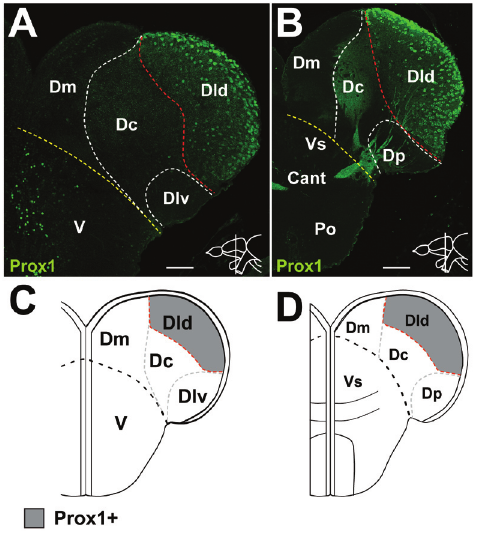
Figure 3. Expression of Prox1 in the pallium. A . At mid-telencephalic levels, Prox1 positive cells are found in the neuronal layer (nl) of Dld shortly before the anterior commissure (Cant). B . At Cant, Prox1 positive cells are found in the nl of Dld. C .– D . Summary of expression pattern of Prox1. A .– B . Confocal images of cross-sections at the levels indicated through the telencephalon. Red dashed line indicates subdivisions based on the current marker. White dashed line indicates subdivisions based on other markers. The yellow dashed line indicates the boundary between D and V. Scale bars = 50µm in A – B .